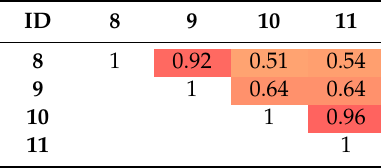
Figure 5. Inside Passage, Alaska study area. ( a ) Mean tidal current speed and ( b ) cross-correlation at points with mean velocity above 50 cm/s and deeper than 10 m with respect to the anchor point (0). Representative points for the correlation analysis are identified on both panels. In this region, the tide propagates northward and the phase lag for the M 2 tidal constituent, the most energetic, is around 25° [22]. However, there is a significant phase difference when the tidal currents are evaluated. Multiple sites show negative correlations as shown in Table 5. Tidal currents north and south of Chichagof Island are out of phase where Point 3 shows correlations between − 0.61 and − 0.4 with points in the north. Overall, the potential to aggregate resources to reduce periods of